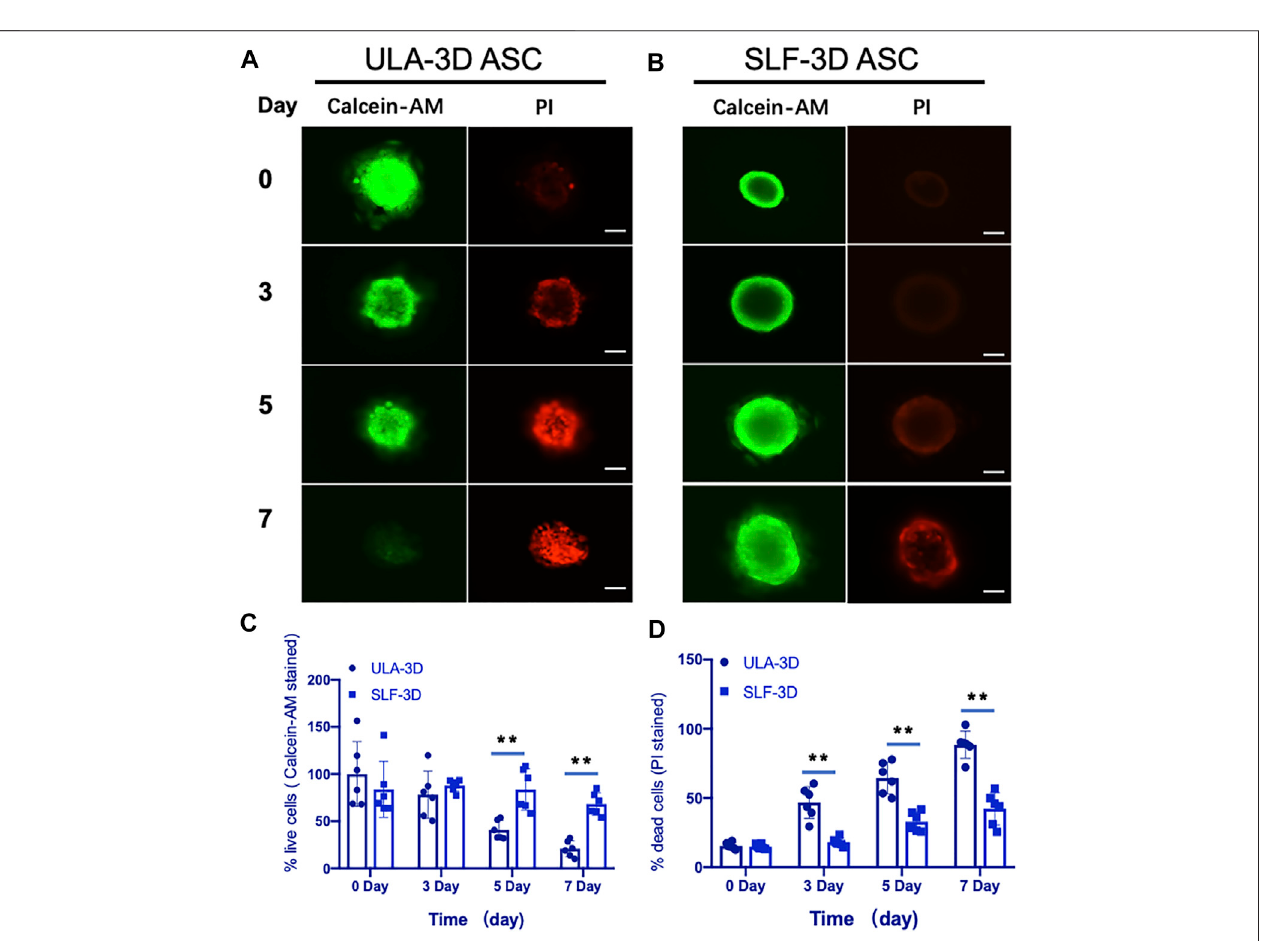
FIGURE 5 | Fluorescence microscopy images of ULA-3D and SLF-3D spheroids stained with Calcein-AM/PI dyes. At 0, 3, 5, and 7 days of spheroid culture, spheroids were stained withCalcein-AM/PI. (A) ULA-3D spheroids; (B) SLF-3D spheroid ASCs, and the quanti fi cation ofthe percentage of (C) Calcein-AMpositiveand (D) PI-positivecellsinimagesofspheroids.Themeanintegratedopticaldensity(IOD)ofallimageswasmeasuredandanalyzedusingImage-ProPlussoftware( n (cid:2) 6),** p < 0.01, as compared with control (0 h) group. Scale bar, 100 μ m.